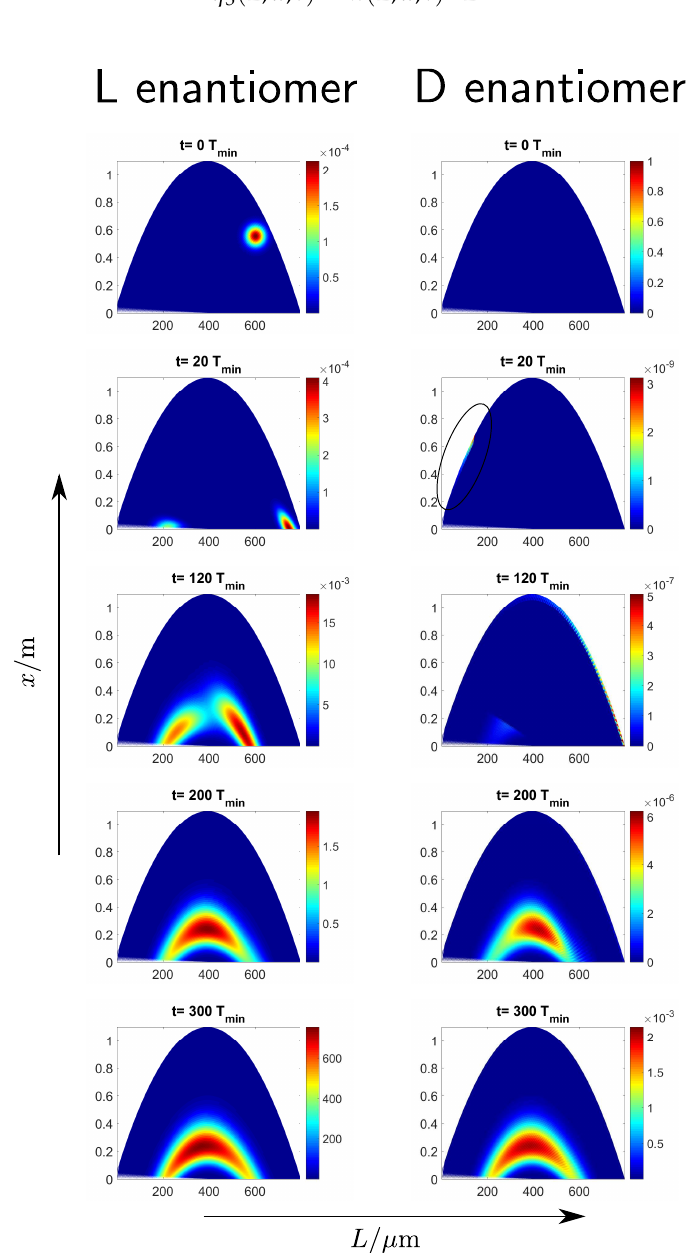
Figure 7. Numerical solution of the linear model by the time stepping scheme using the parameter values from Table 1; crystal size L on the horizontal axis, space coordinate x on the vertical axis. Snapshots of the mass related size distribution q 3 for the desired L enantiomer and the undesired D enantiomer are shown for the case that initially there are only L seeds in the crystallizer. Minimum residence time and step size for numerical solution is equal to T min = 718s. L and D populations gradually approach bimodal distributions with a counter-flow of rising small crystals and sinking big crystals. Note the different scaling of the diagrams for L and for D. The D size distribution at time t = 20 T min shows a small peak encircled in the